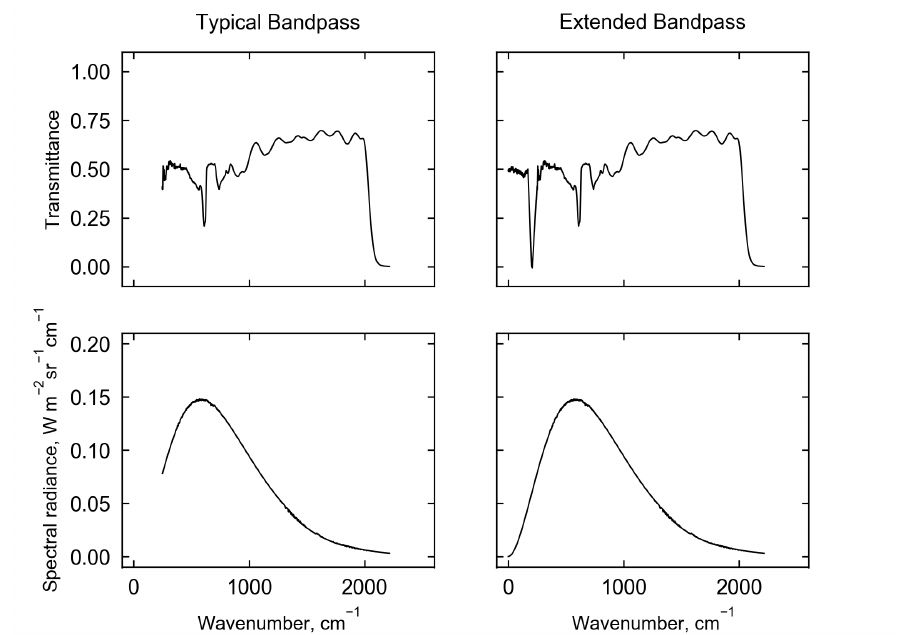
Figure 5. A comparison of dome transmittance for the model CG3 Kipp and Zonen silicone domed pyrgeometer on the CNR01 4-component system used during BUBBLE (data supplied by Kipp and Zonen, pers. comm.) and at-sensor radiance (T surf = 300 K, T air = 300 K, z = 30 m) for “typical” and extended